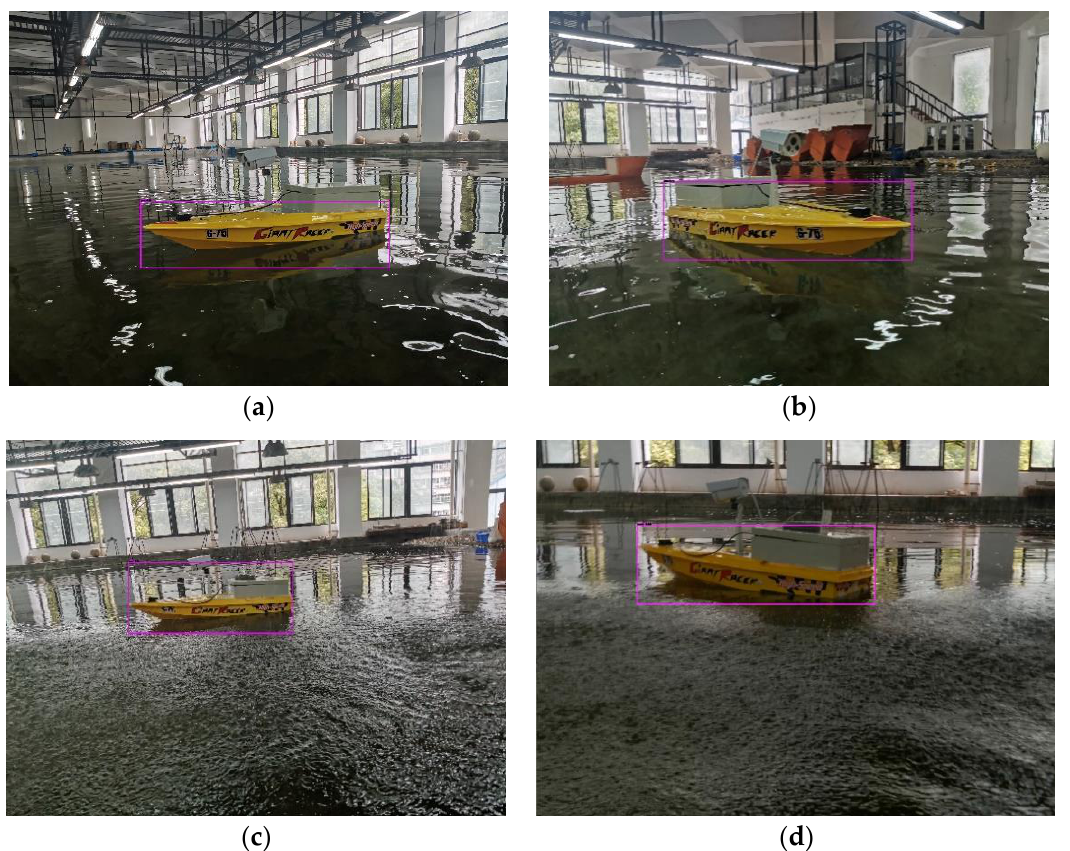
Figure 8. Target detection results under background interference in experimental pool. ( a ) Ship target detection under the background of backlight. ( b ) Ship target detection under backlight and object interference. ( c ) Ship target detection under backlight and simulated rain. ( d ) Ship target detection under simulated rain and insufficient illumination.